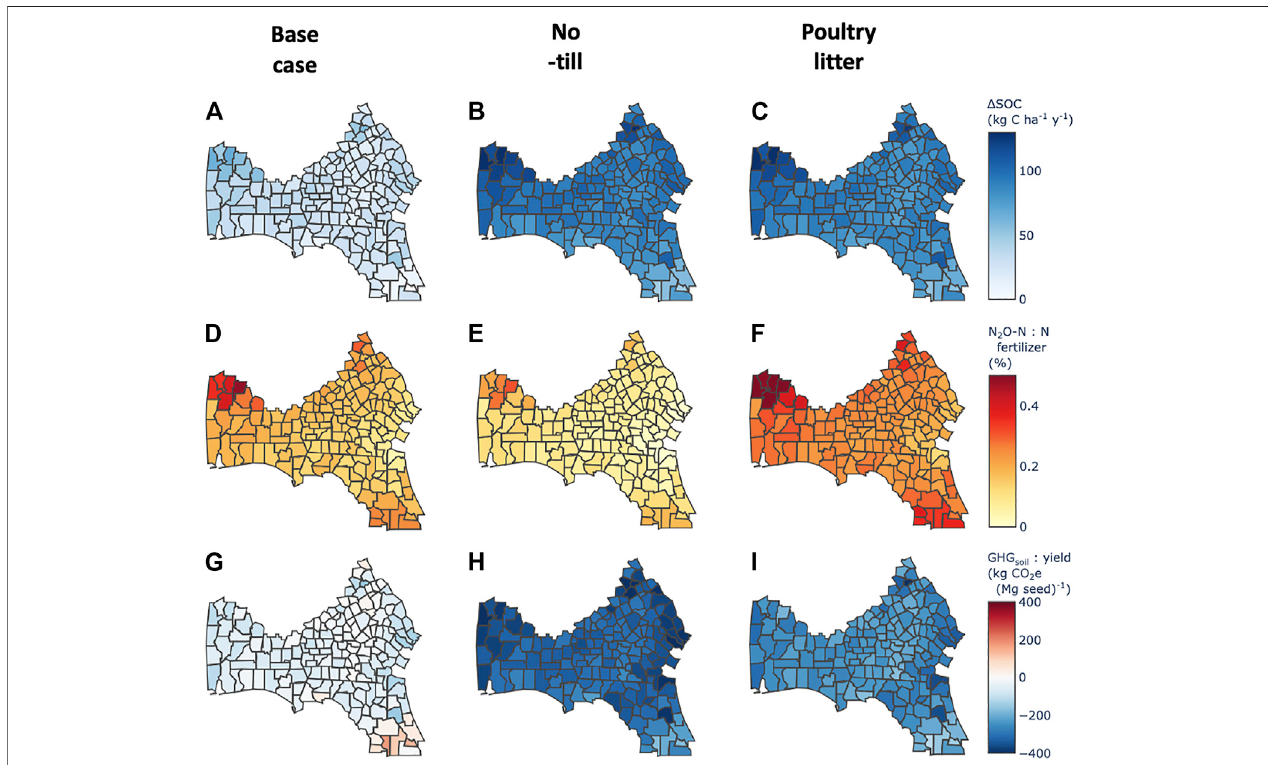
FIGURE5| DayCent-simulated soil GHG fl uxesunderdifferentcarinata cultivation scenarios,relative tothe continued business-as-usual referencerotation. (A – C) increase in soil organic carbon storage. (D – F) The fraction of new N applications lost in the form of direct nitrous oxide emissions. (G – I) The net soil GHG footprint of carinata seed production, which re fl ects the sum of positive CO 2 -equivalent emissions from additional N 2 O production, plus negative CO 2 -equivalent emissions associated with an increased soil sink of carbon and CH 4 .